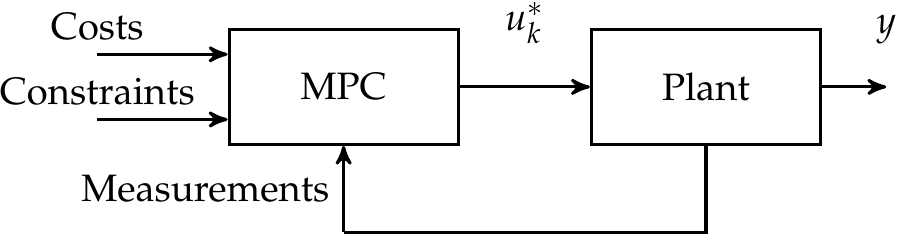
Figure 1. A simple MPC scheme.